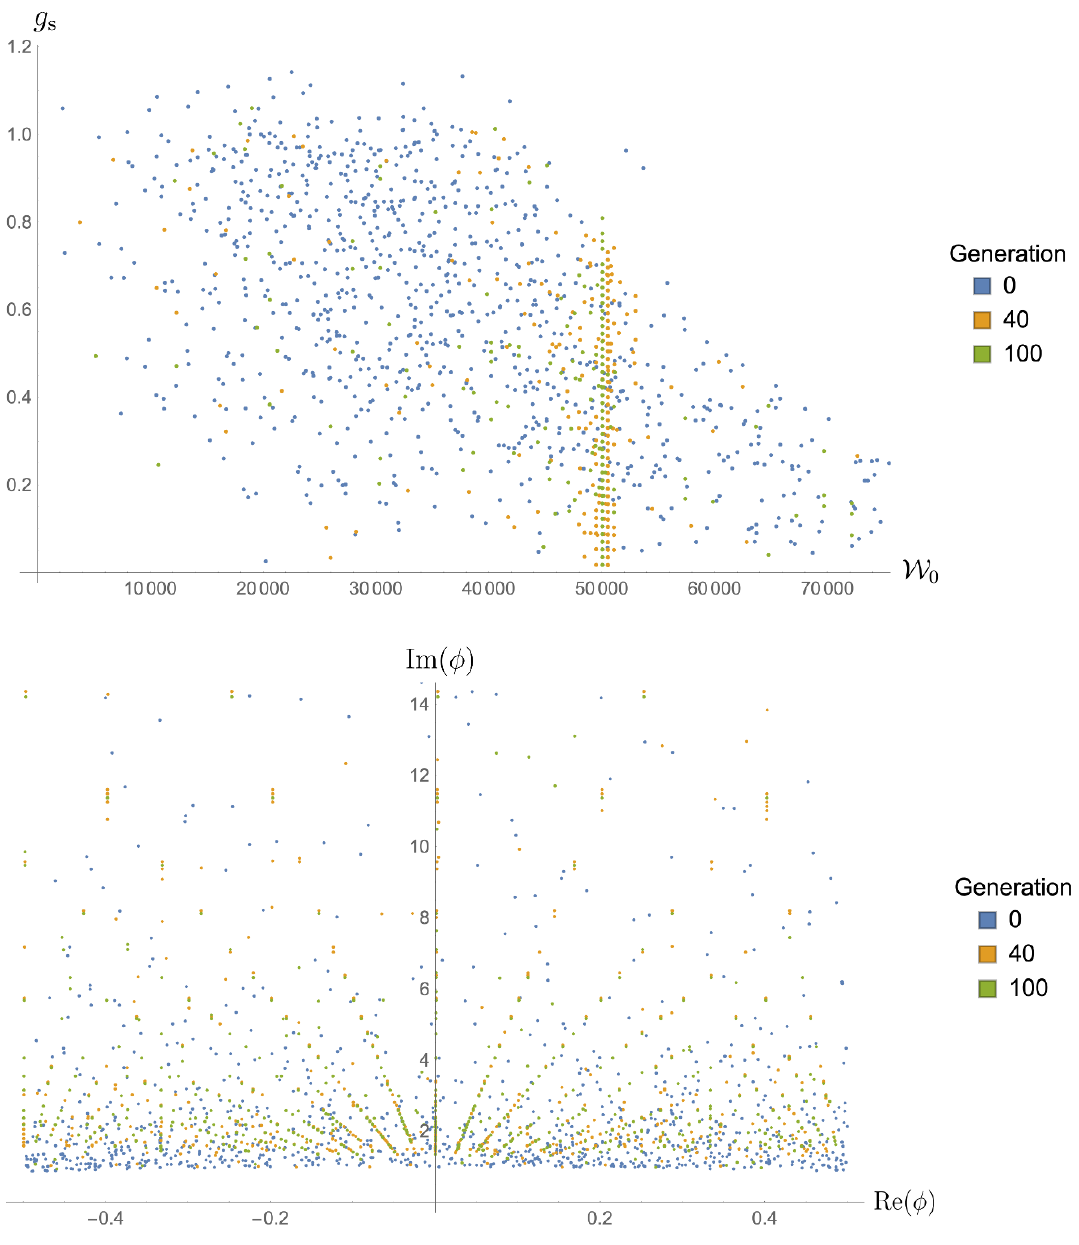
Figure 3 . Distribution of g s , W 0 and (cid:30) for three